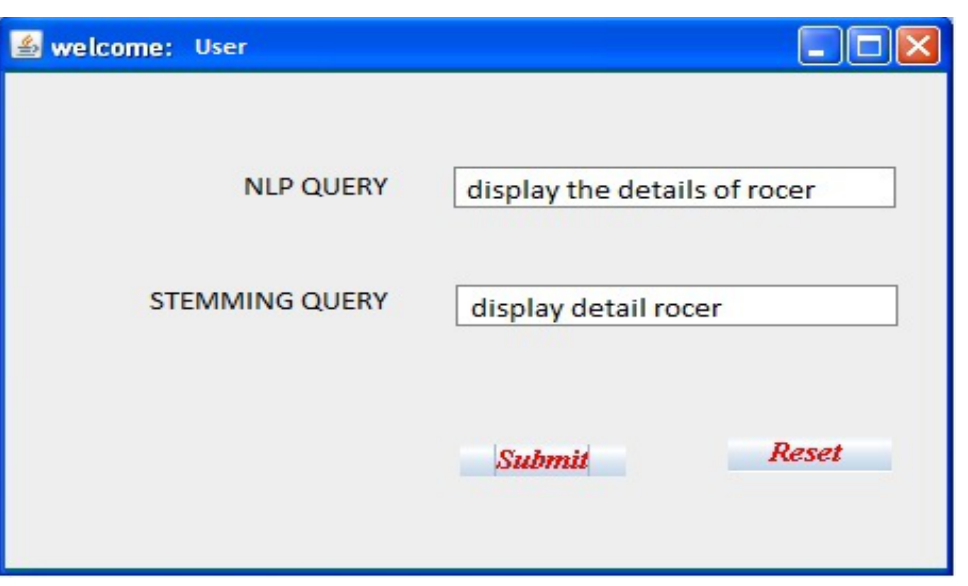
Figure 6 . Query conversion.